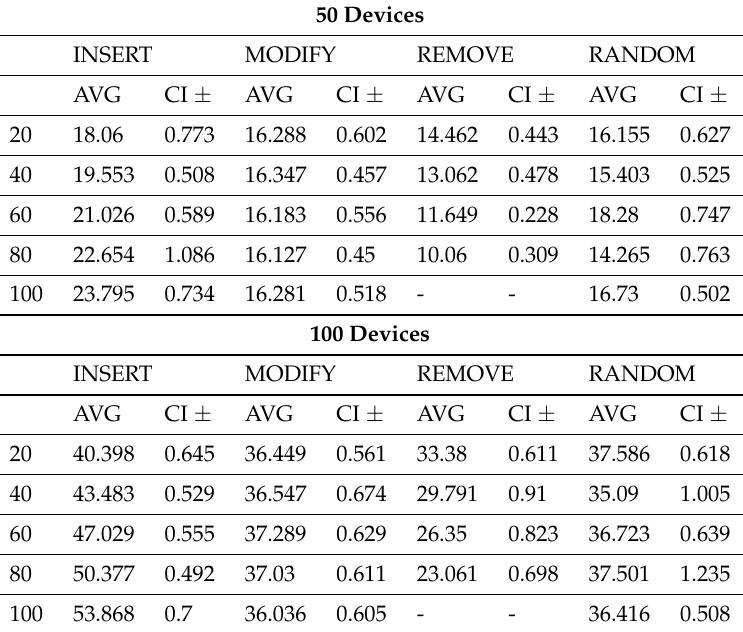
Table A1. The obtained results from the data model comparator. The average time (AVG) and confidence interval (CI) of the execution time needed